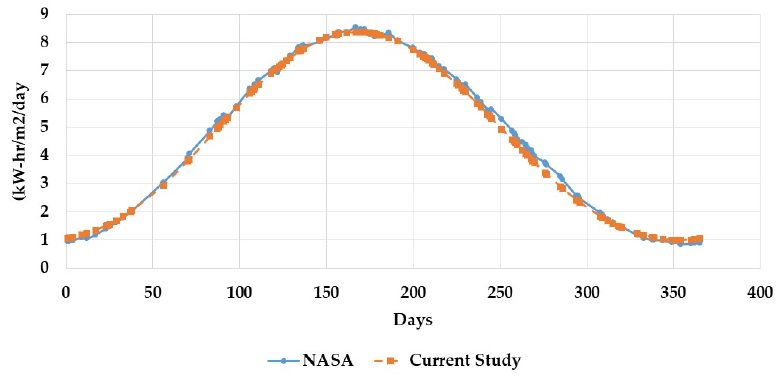
Figure 14. Comparison of the clear-sky global horizontal radiation of current study and that of NASA.